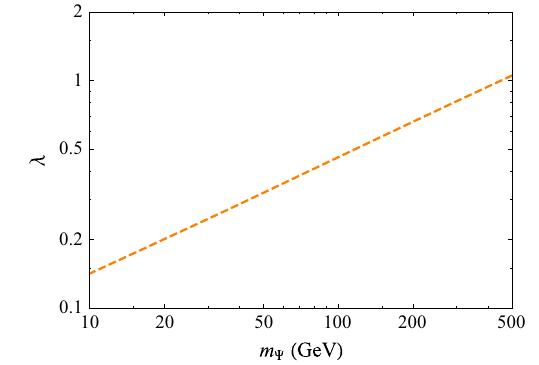
Fig. 1 The effective coupling λ as a function of SIDM mass m (cid:3) , with m (cid:3) in a range of 10–500 GeV. Here the relic fraction of SIDM f SIDM (cid:6) 99.6% is